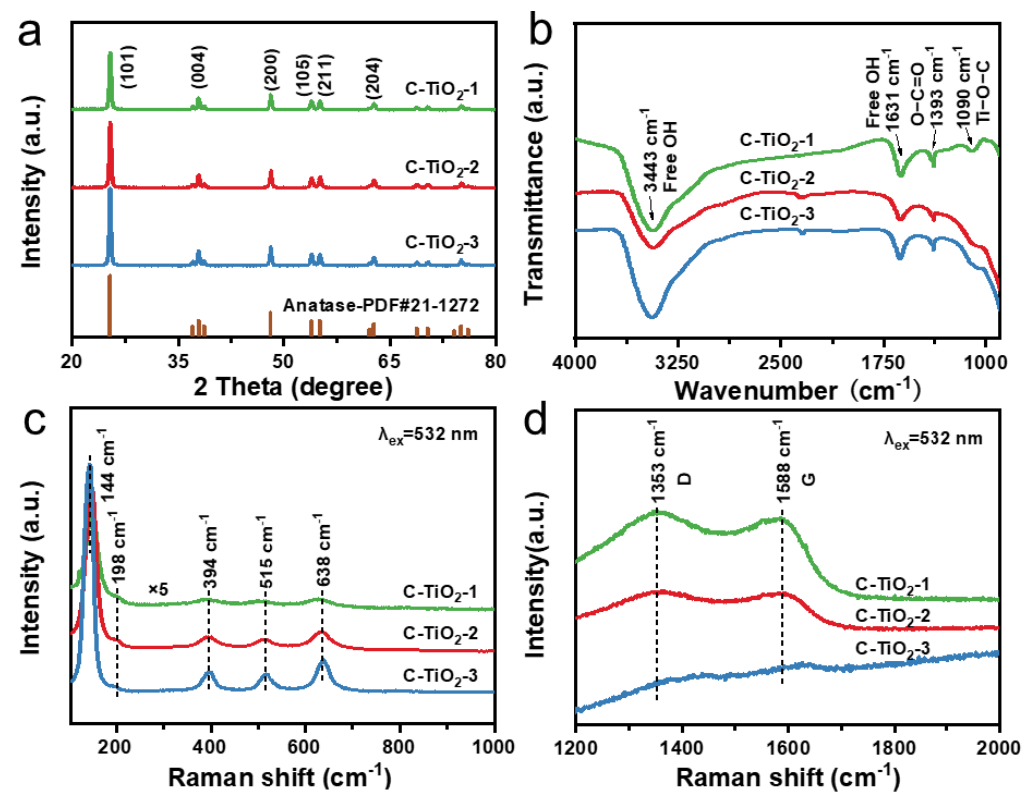
Figure 3. ( a ) Powder XRD patterns of the obtained C–TiO 2 –1, C–TiO 2 –2 and C–TiO 2 –3 photocatalysts. ( b ) FTIR spectra of the corresponding samples. ( c , d ) Raman spectra of the corresponding samples.